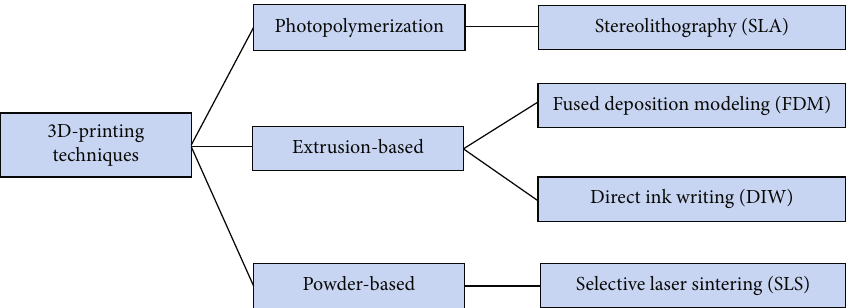
Figure 6: 3D printing techniques for polymers [175].